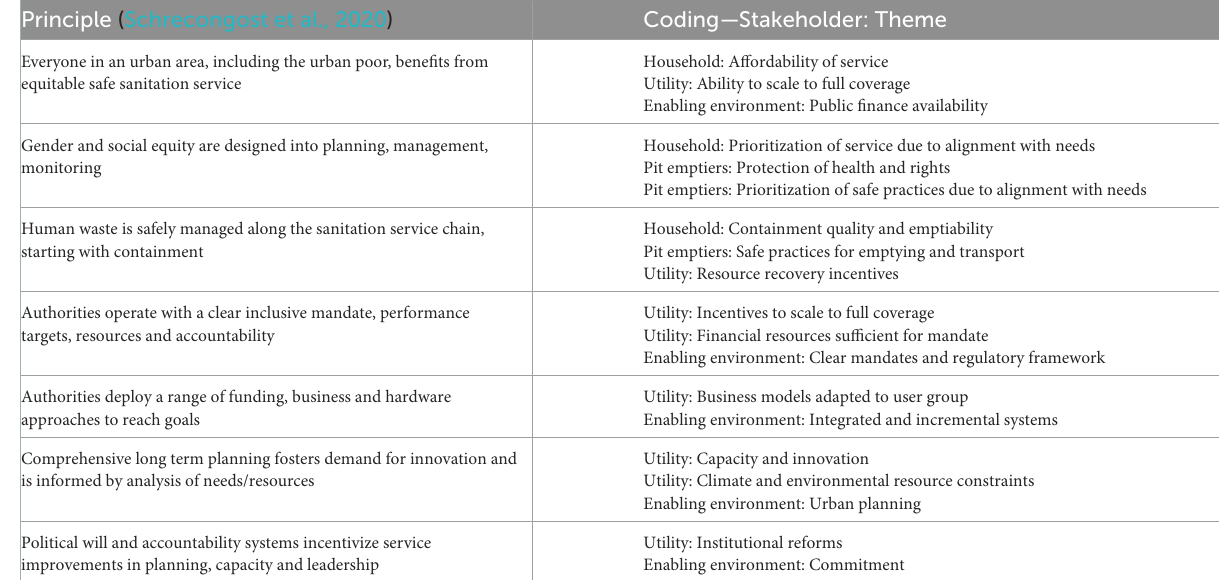
TABLE 2 Initial coding